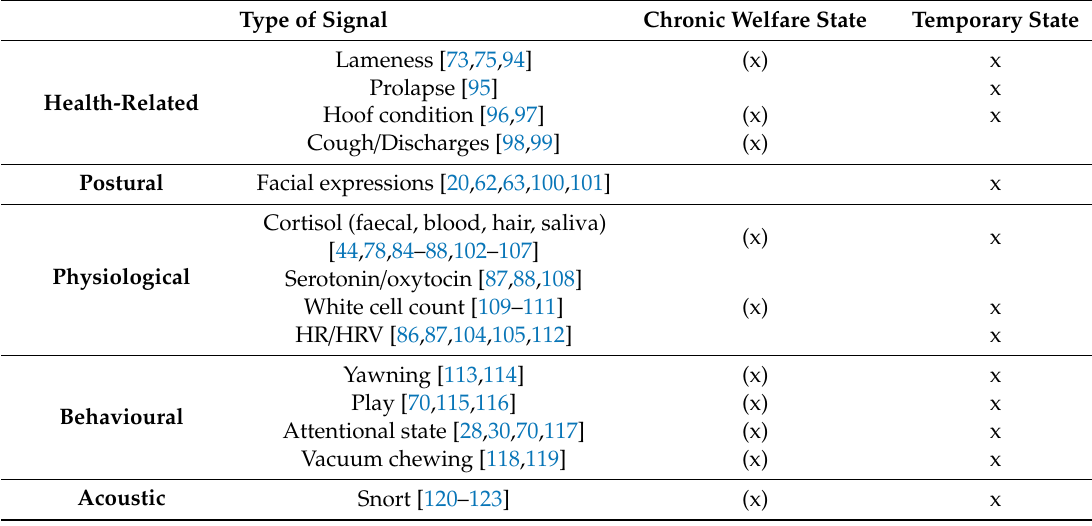
Table 2. Signals potentially related to horses’ welfare. X: indicates whether signal reveals a chronic welfare state, temporary state or a veterinary issue. (X): indicates whether signal may be a predictor of chronic welfare state, temporary state or a veterinary issue when combined to other signals. References are given in italics for each